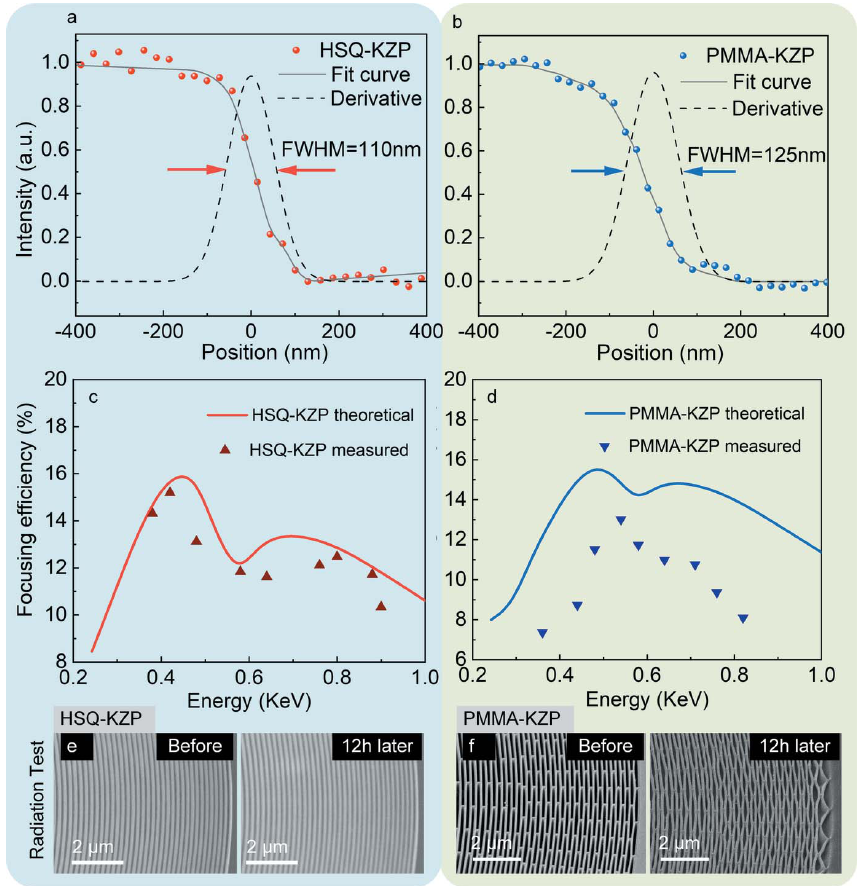
Figure 5 ( a , b ) Focusing spot profiles for soft X-rays by the HSQ-KZP and the PMMA-KZP lens measured by knife-edge scan method with dwell time of 1 ms and step size of 25 nm, where the dots are the raw data, the solid lines are the fitting curves and the dash lines are the first-order differentials of the raw data. The first-order derivatives of the scanned curves give rise to a full width at half-maximum (FWHM) of 110 nm for the HSQ-KZP lens and 125 nm for the PMMA-KZP lens. ( c ) Comparison between the measured focusing efficiencies of HSQ-KZP and the theoretical ones using the BPM- QDHT approach. ( d ) Measured focusing efficiencies of the PMMA-KZP lens compared with its theoretical value calculated by the BPM-QDHT approach. ( e , f ) Comparison of X-ray radiation damage to the dielectric zone plates by the SEM images of the outermost zones in the HSQ-KZP lens and the PMMA-KZP lens, after 12 h soft X-ray radiation in the